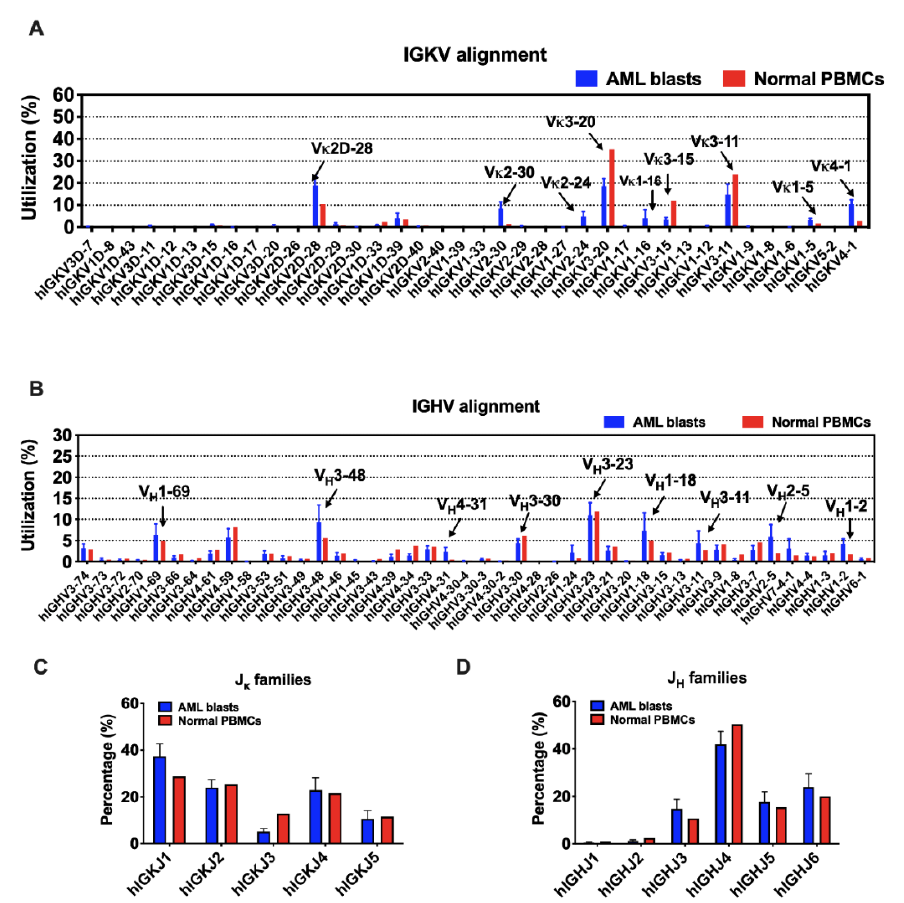
Figure 3. The usage of V and J segments in AML blasts and normal PBMCs. ( A ) Usages of human IGKV gene segments selected by AML blasts and normal PBMCs. The order of IGKV gene segments on the X-axis is according to that on the chromosome. ( B ) Usages of human IGHV gene segments selected by AML blasts and normal PBMCs. The order of IGHV gene segments on the X-axis is according to that on the chromosome. ( C ) Usages of human IGKJ families by AML blasts and normal PBMCs. ( D ) Usages of human IGHJ families by AML blasts and normal PBMCs. Bars indicate mean ±